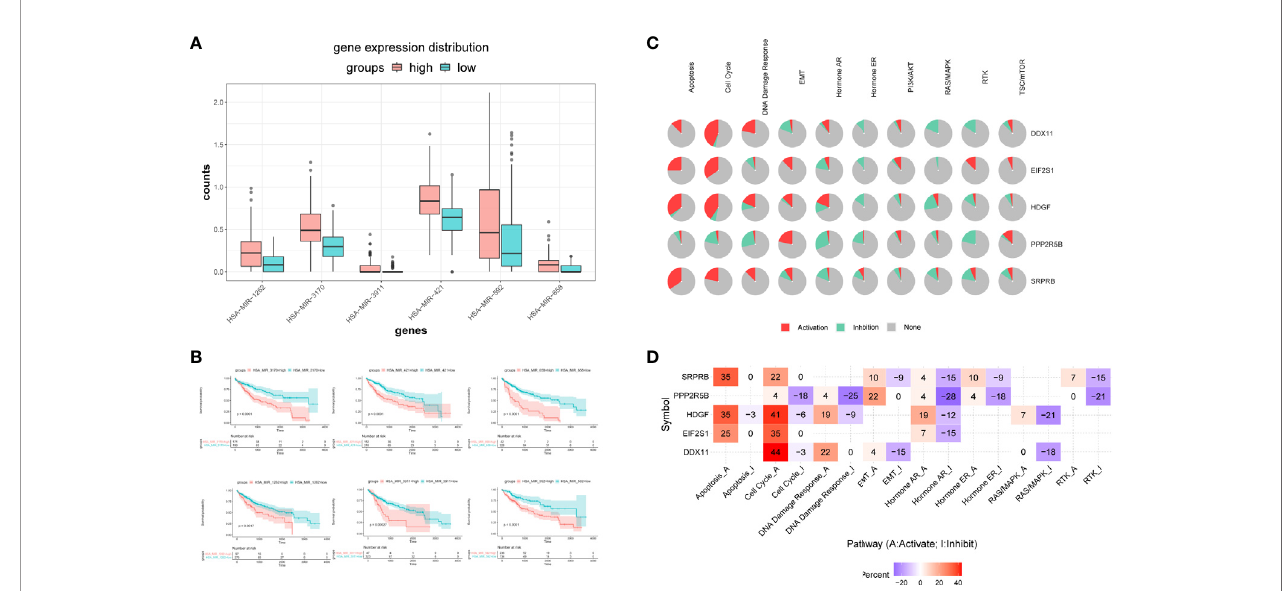
FIGURE 10 | Expression distribution and survival analysis of miRNA in the TCGA dataset. (A) miRNA expression distribution in different risk groups. (B) KM survival analysis of 6 miRNAs. (C) Functional analysis of 5 target genes. Red and green in the pie chart represent the direction and proportion of expression. (D) Inferred activity of the identi fi ed 5 target genes in biological pathways. A and I to mark the active and inhibited pathways,